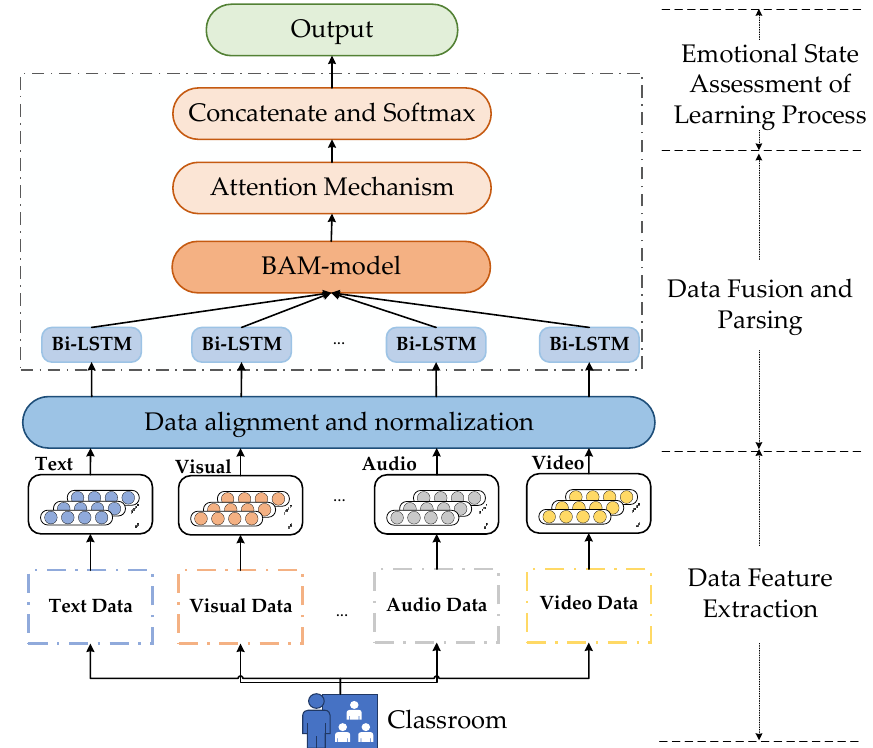
Figure 1. Overall architecture diagram of a cross-modal collaborative analysis model.